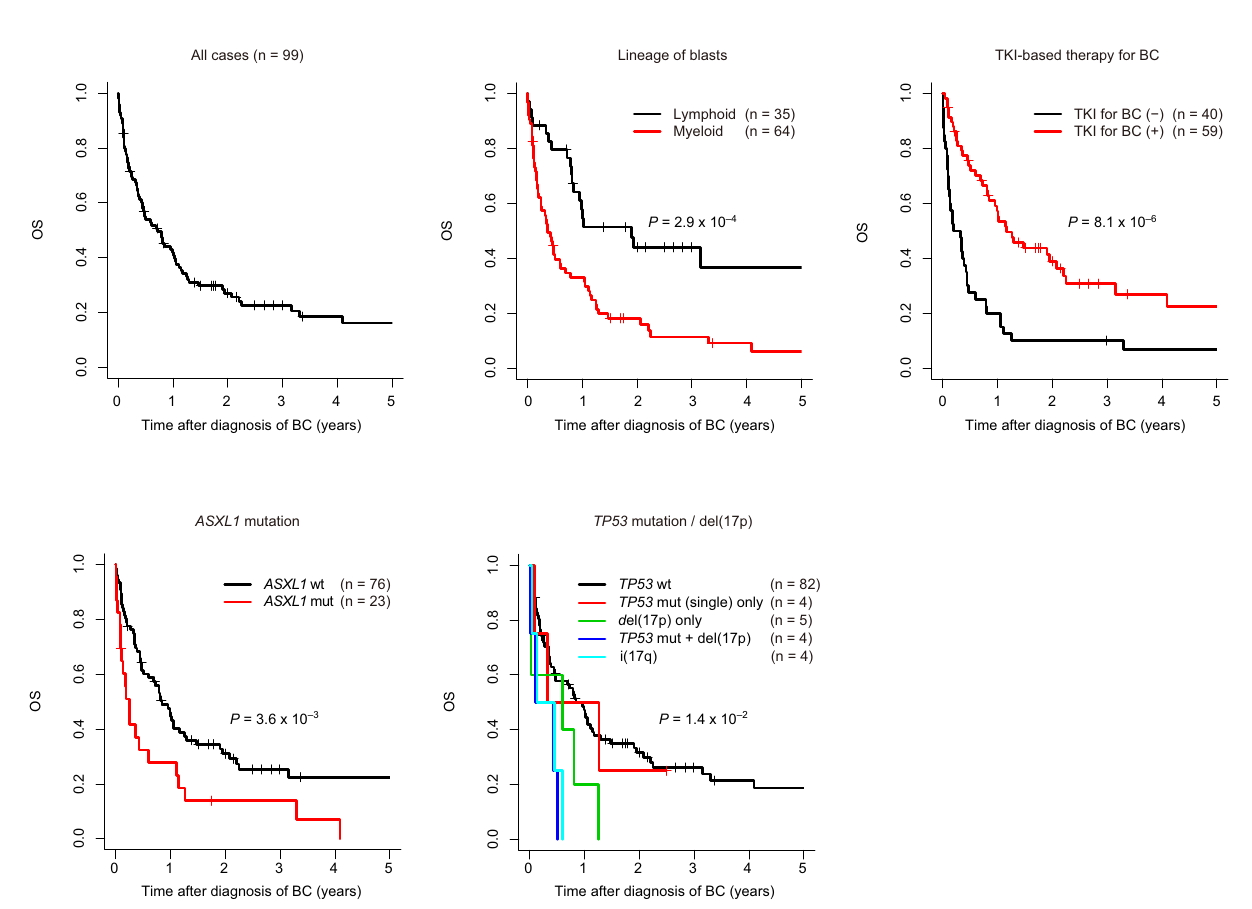
Fig. 4 Prognostic relevance of genetic abnormalities in CML-BC. Kaplan – Meier survival curves for OS in 99 patients with CML-BC according to the indicated clinical or genetic factors. The prognostic impact of each factor on OS was calculated using the log-rank test. For TP53 mutations and/or del(17p), we classi fi ed patients according to the presence or absence of TP53 mutations, del(17p), and i(17q), based on which patients were divided into the following fi ve groups: patients (1) without any TP53 mutations/del(17p)/i(17q), (2) with TP53 mutations alone, (3) with del(17p) alone, (4) with concurrent TP53 mutations and del(17p), and (5) with i(17q). One patient harboured two distinct TP53 mutations, as well as del(17p), and was classi fi ed into group 4. No patients with i(17q) harboured TP53